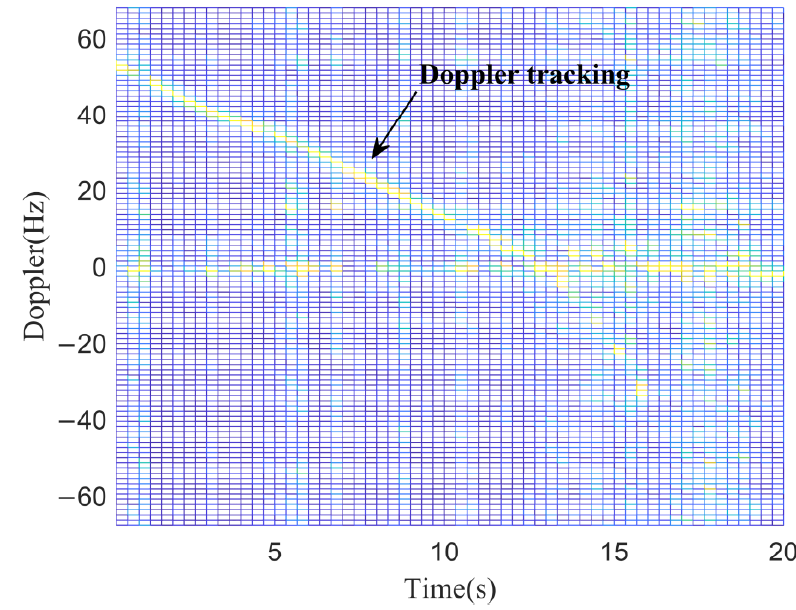
Figure 23. Target Doppler trajectory tracking results.